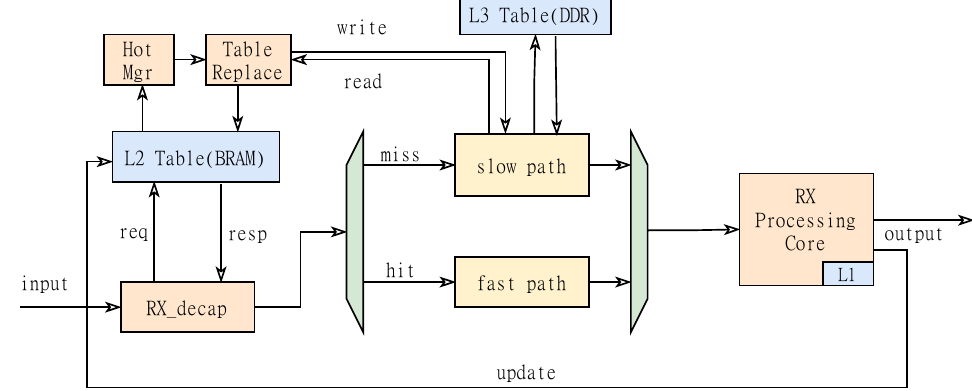
Figure 4. Schematic diagram of state table hot